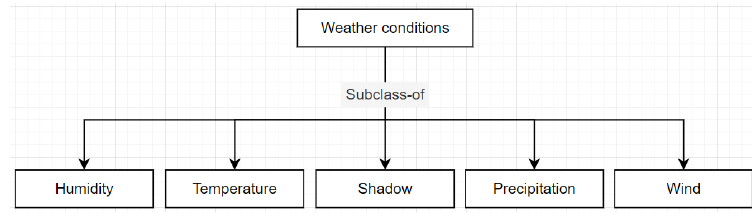
Figure 3. Taxonomy of the Weather conditions